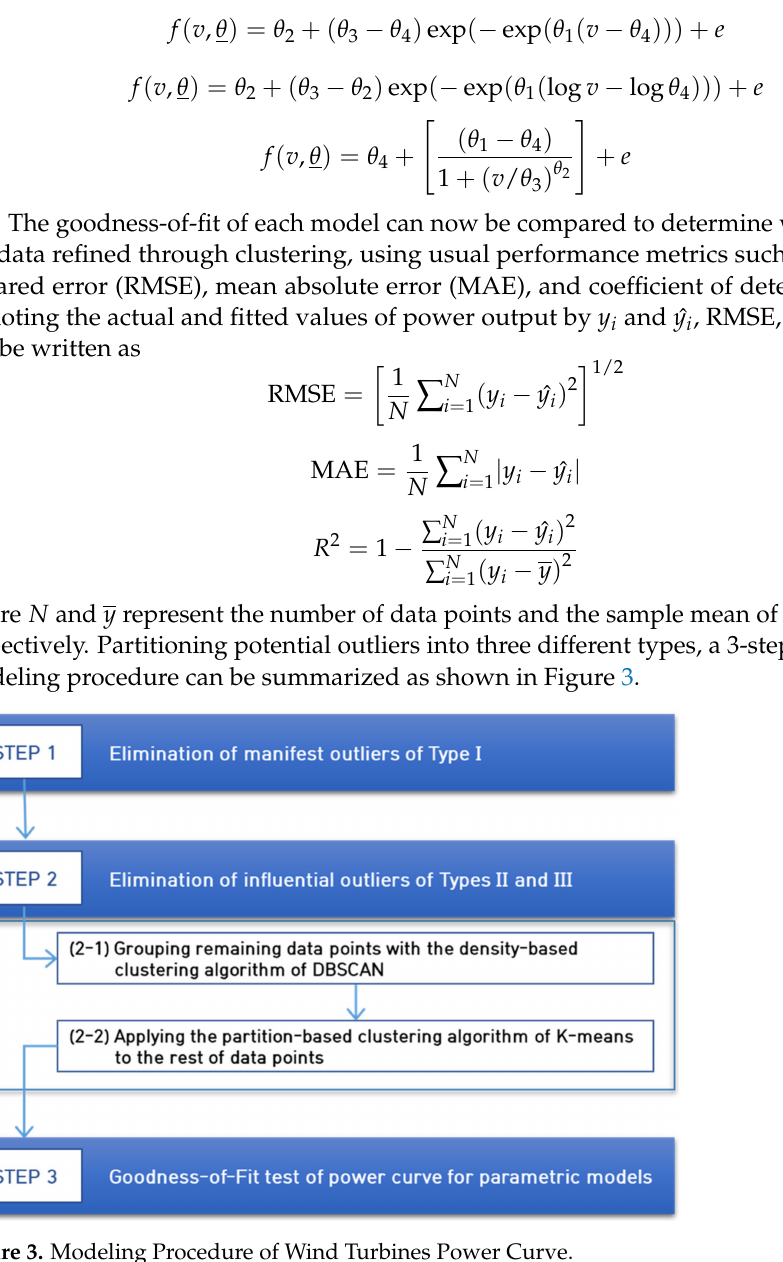
Figure 3. Modeling Procedure of Wind Turbines Power